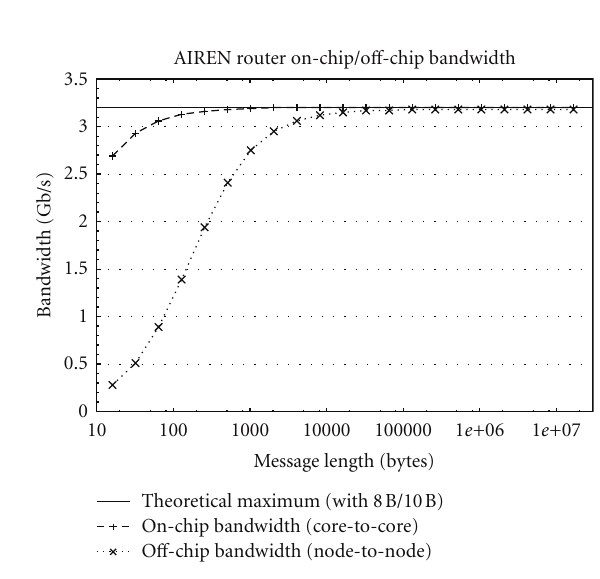
Figure 6: on-chip and o ff -chip bandwidth of AIREN network with hardware based